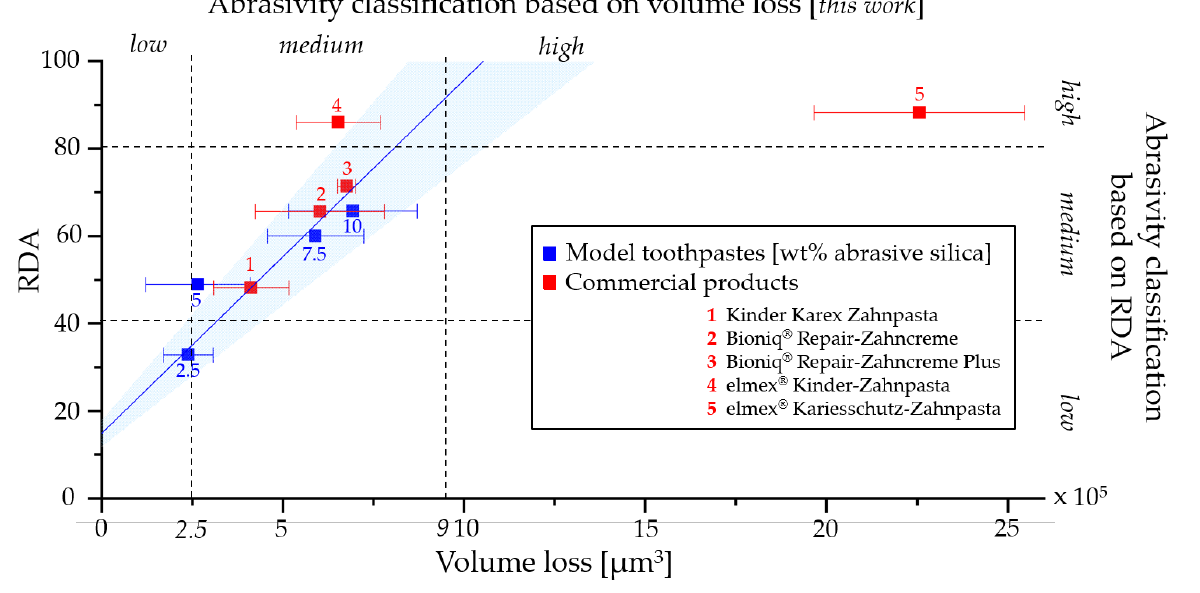
Figure 8. Correlation between measured volume loss and the experimentally determined RDA values obtained for the model toothpastes (blue) and the tested commercial products (red). The model toothpaste regression curve serves as the calibration curve for predicting the RDA values of the commercial products (see Table 3). The area shadowed in blue represents a deviation of 20% in the RDA values above and below the calibration curve [8]. RDA values within this range can be considered to be well predicted by our experimental approach. The dashed lines describe the classification of all tested toothpastes (low, medium and high abrasivity) according to our approach ( x -axis) and according to an established classification for RDA by Hamza et al. [34].